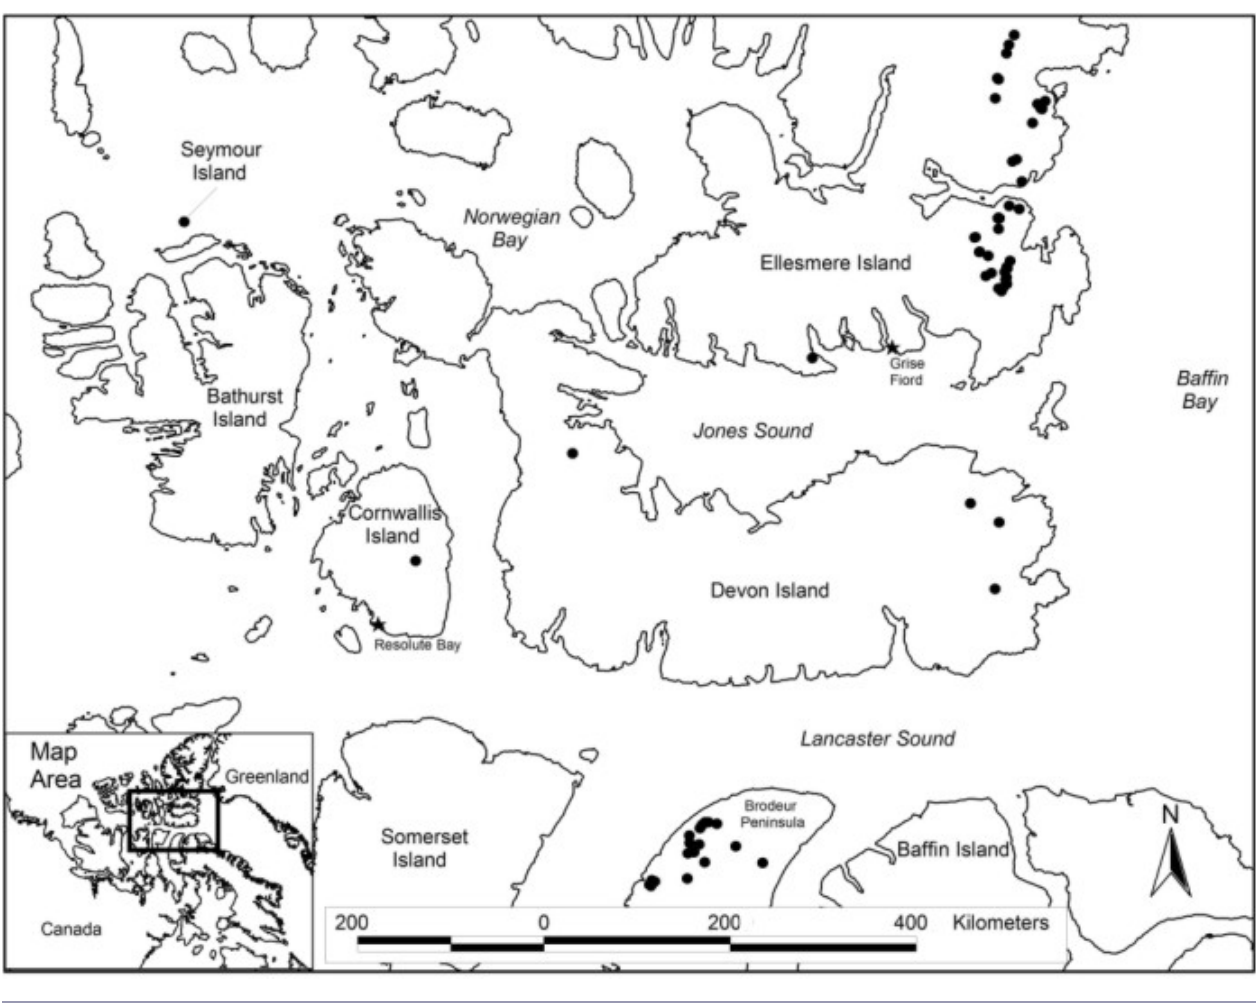
Fig. 1. Locations (circles) of Ivory Gull colonies in Arctic Canada. Stars represent human